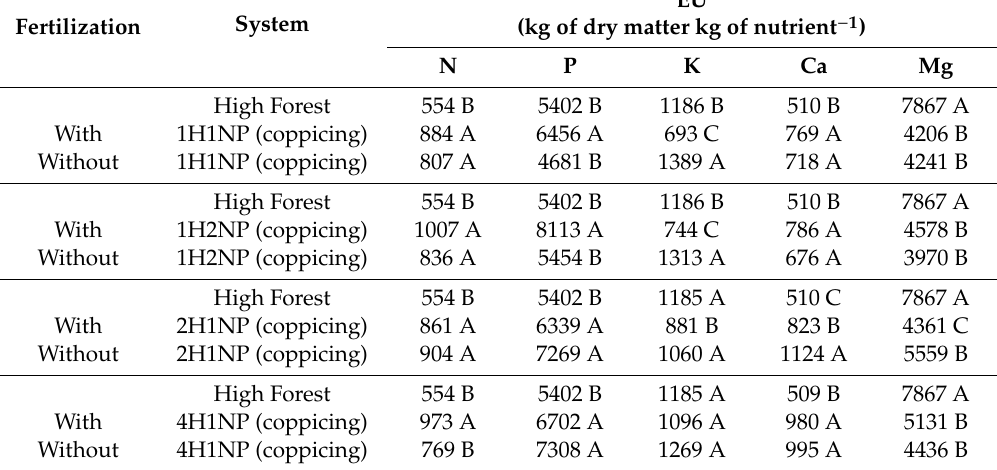
Table 8. E ffi ciency utilization (EU) of nutrient for the production of trunk mass in eucalyptus (clone GG157), at 60 months of age, managed by high forest and coppicing, influenced by liming / fertilization (With or Without) and height (H) and number (NP) of poles per stump at the time of pole selection.